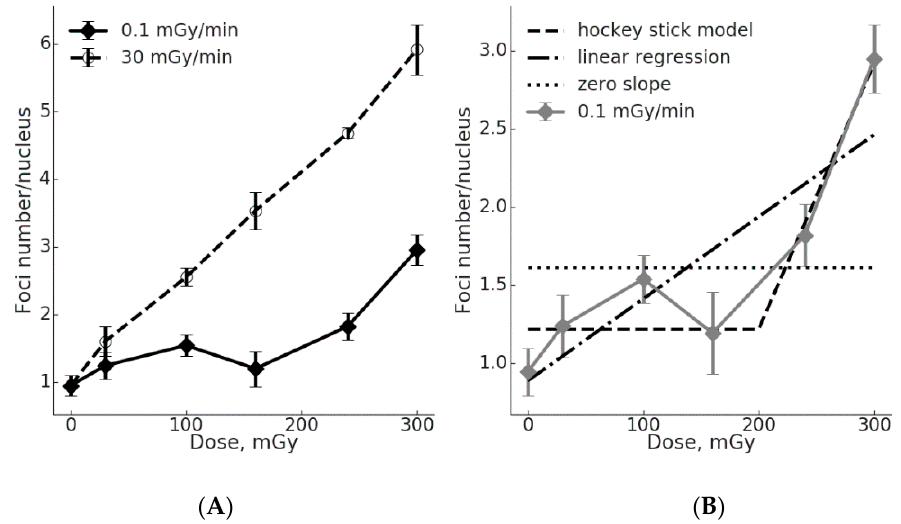
Figure 2. Dose-effect curves for pATM foci formation in γ -irradiated MSCs. ( A ) Data generated using either acute or low dose-rate exposure are shown. The mean and SEM of at least three independent experiments are shown on the y -axis. ( B ) Fitting the pATM foci data for chronic exposure using a “hockey stick” model (threshold at 150 mGy), a linear regression with a positive slope or a liner regression with a nil slope. See text for details.